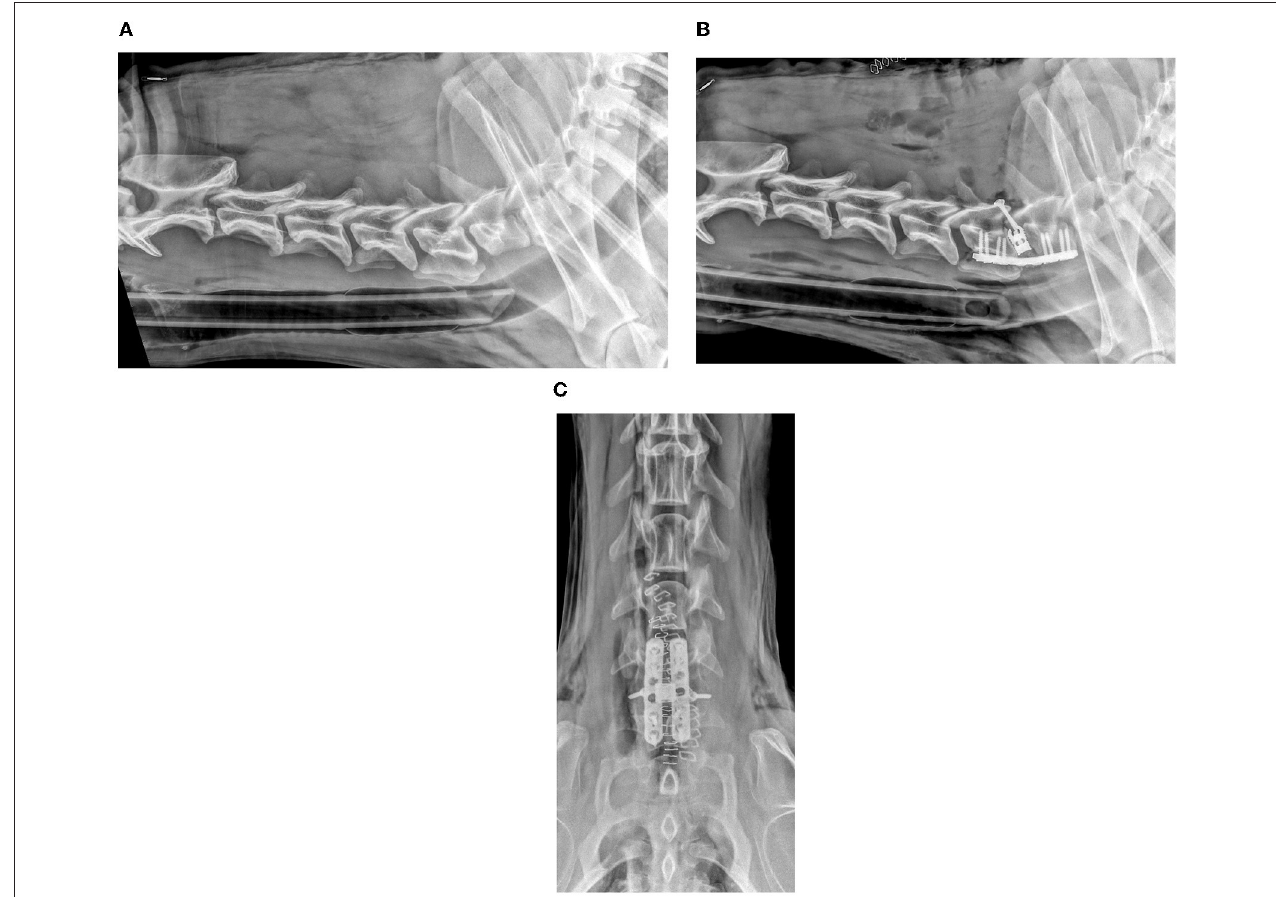
FIGURE 2 | Lateral pre-operative (A) and post-operative (B) and ventro-dorsal post-operative (C) radiographic views of a dog with distraction-stabilization using intervertebral cage, two parallel ventral locking plates, and two dorsal trans-articular